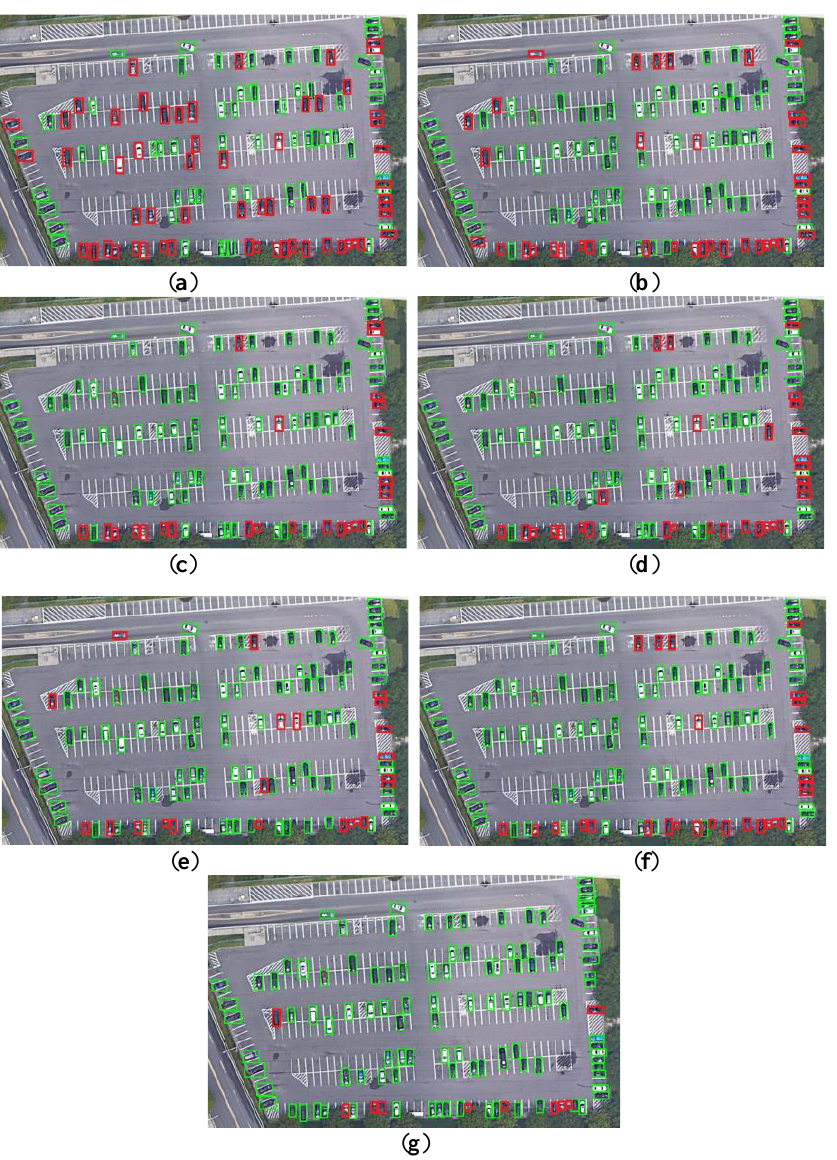
Figure 14. RSI detection results: ( a ) SSD512, ( b ) faster RCNN-FPN, ( c ) RetinaNet, ( d ) cascade RCNN-FPN, ( e ) Foveabox, ( f ) FCOS, ( g ) our model.